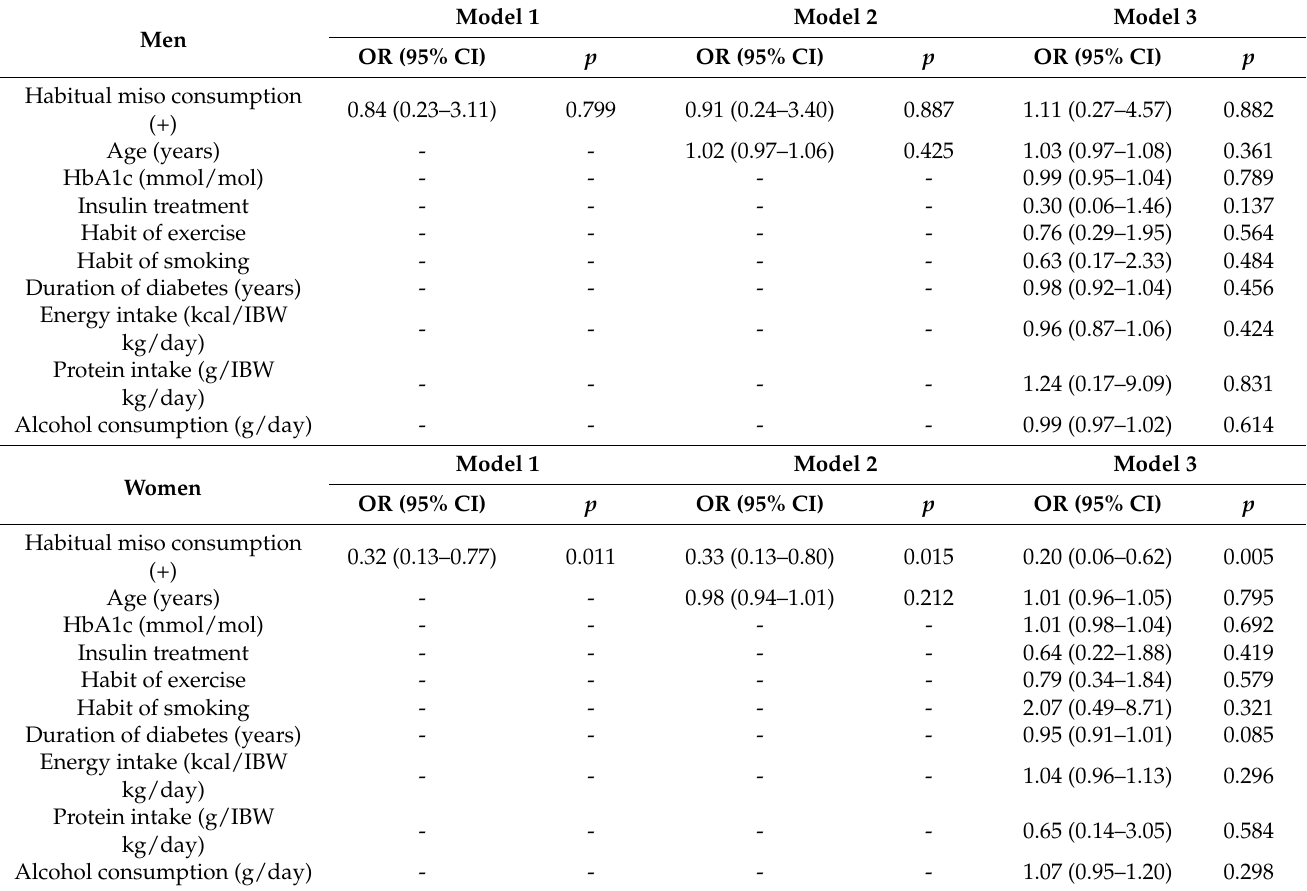
Table 5. Odds ratio of habitual miso consumption on the presence of sarcopenia.